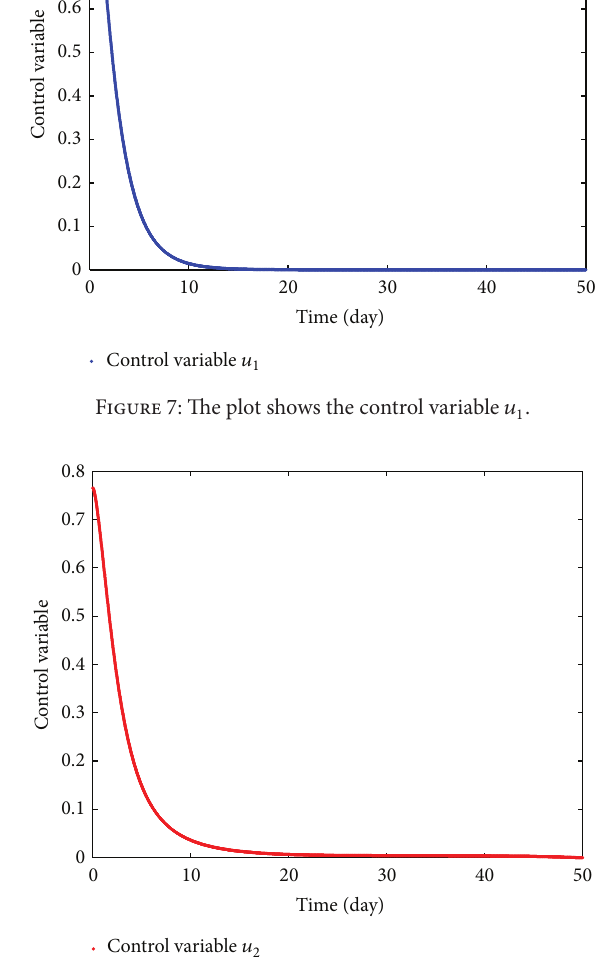
Figure 8: The plot shows the control variable 𝑢 2